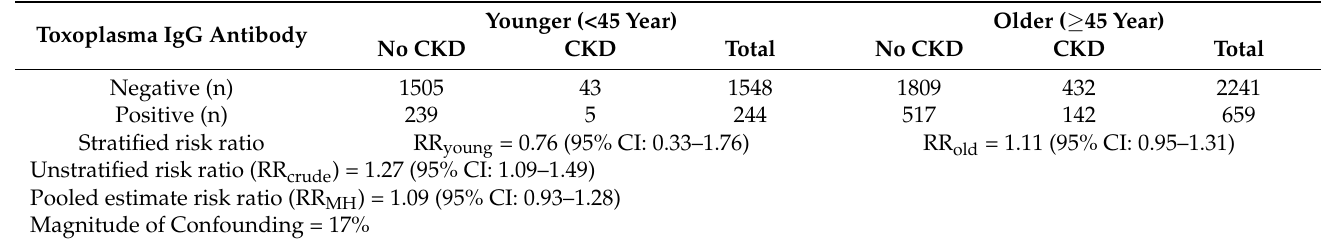
Figure 2. Age distribution by T. gondii exposure status and CKD status. Table 3. Association between T. gondii exposure status and CKD status stratified by age.